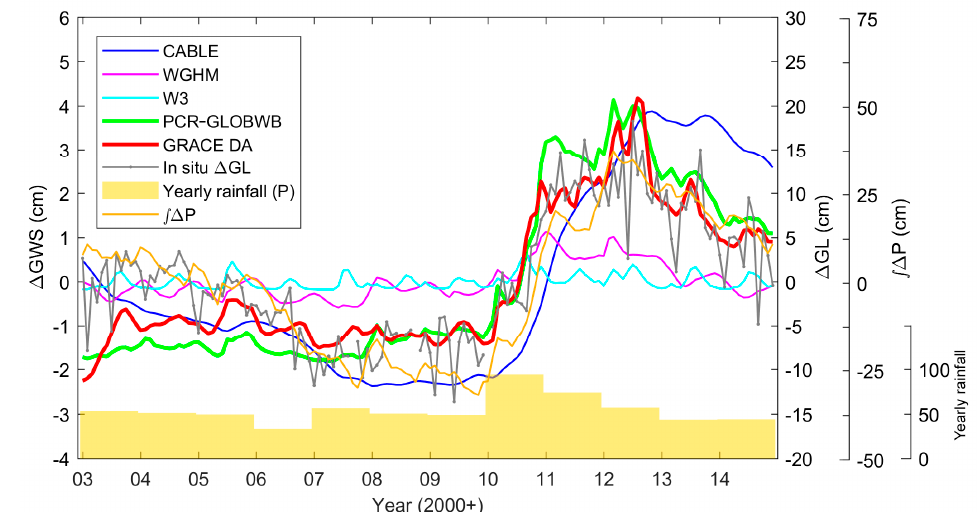
(cid:82) ∆ P (see text for the